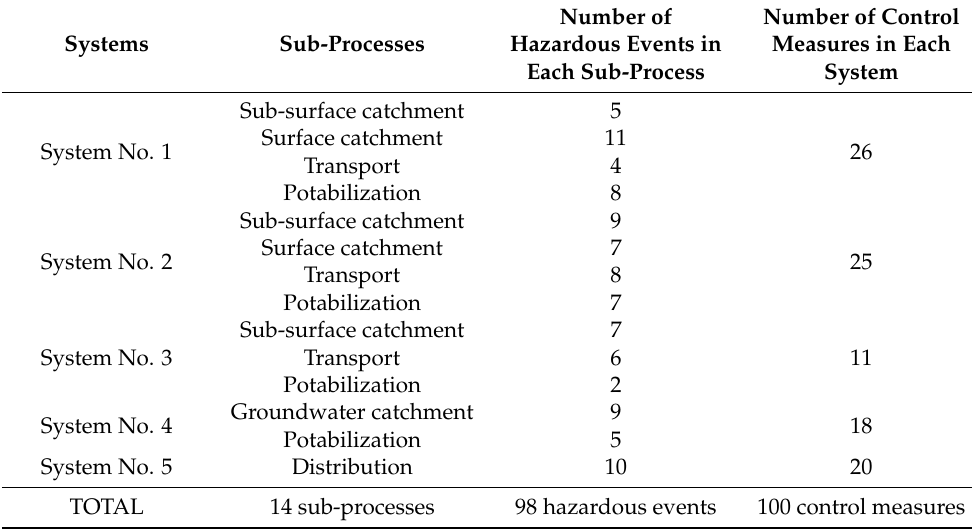
Table 2. Summary of systems, sub-processes, number of hazardous events, and number of control